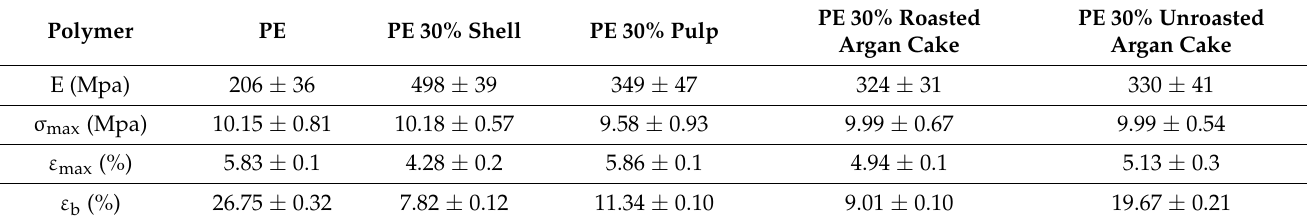
Table 4. Summary of mechanical property results. Young’s modulus (E), maximum tensile